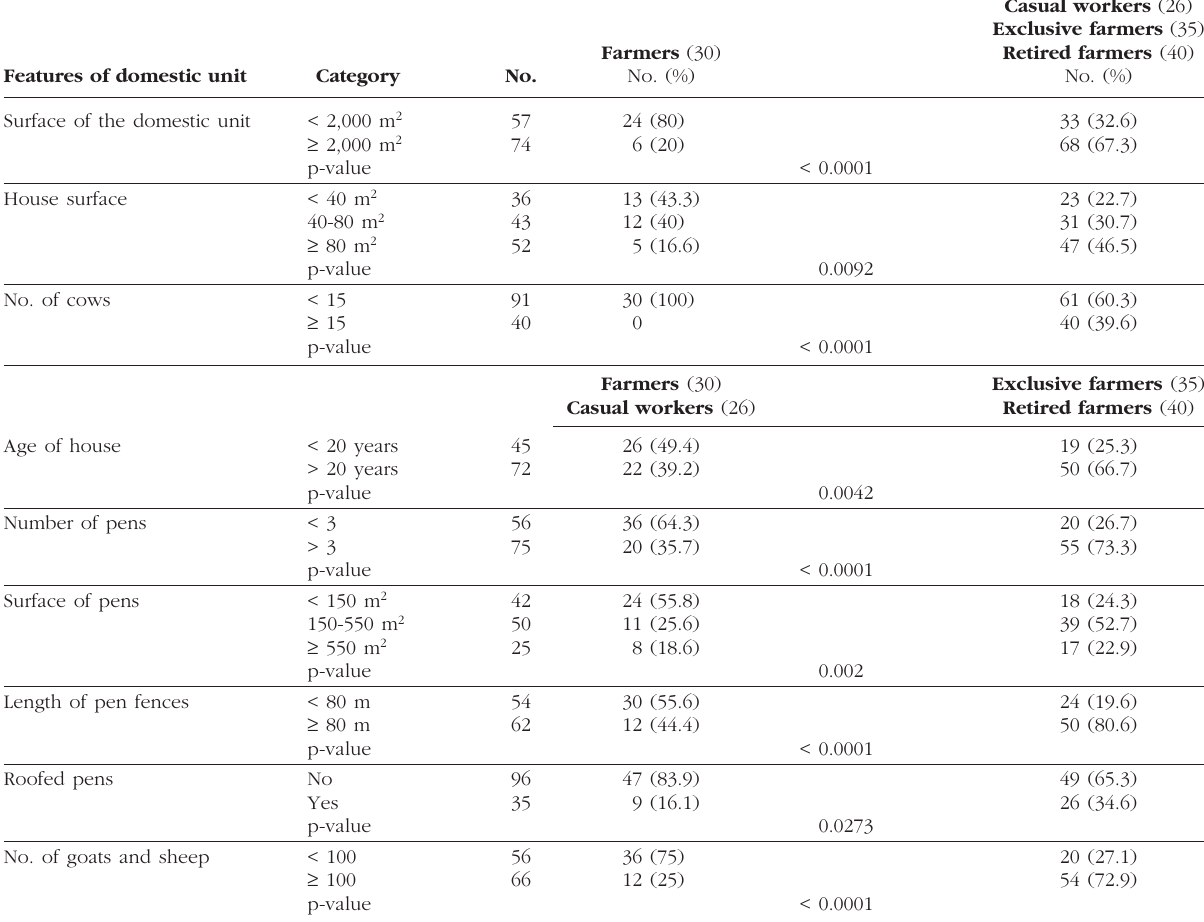
Table I. – Characteristics of domiciliary unit in the four agropastoral groups issued from the population